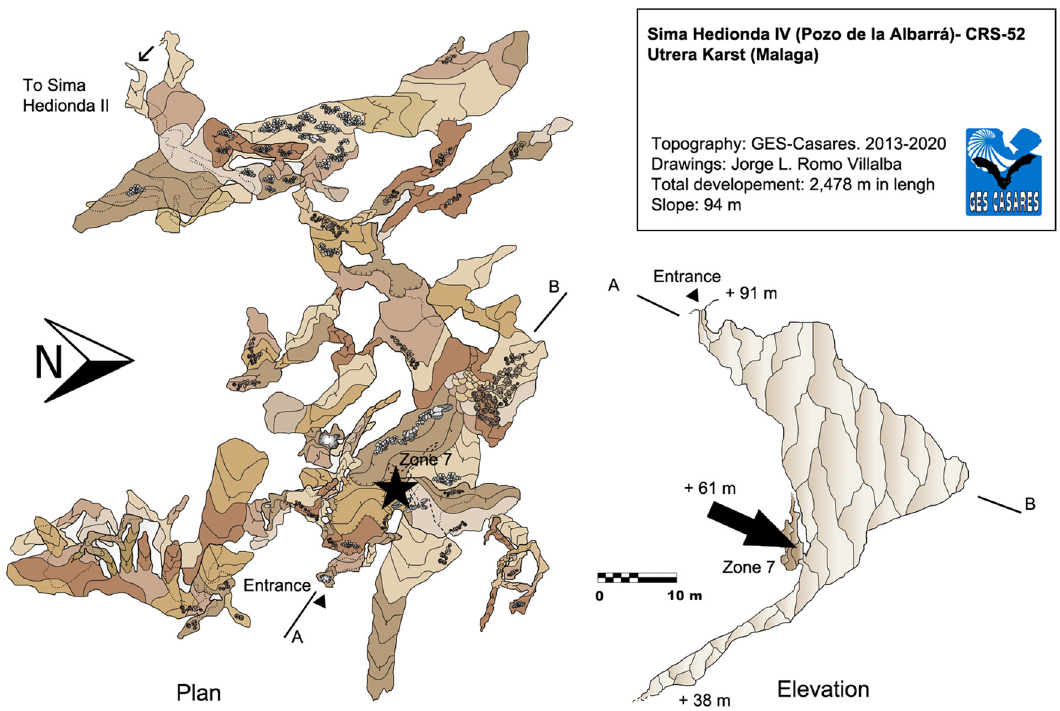
Figure 2: Plan ( left ) and elevation ( cross - section ) ( right ) of Sima Hedionda IV Cave. The fi gure shows the fi nding place ( sector 7 ) : a black star in the plan, and a black arrow in elevation ( cross - section ) . Topography, drawings, and reference data by GES - Casares cavers